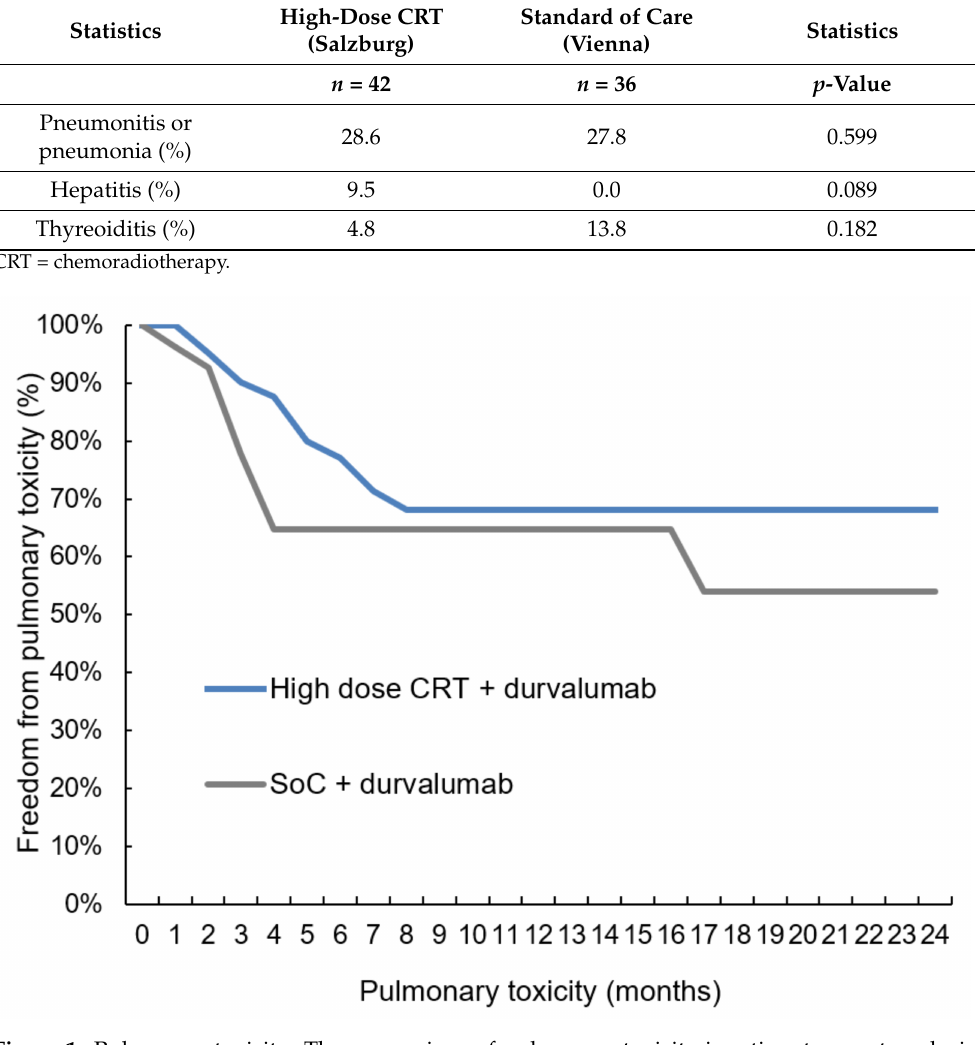
Figure 1. Pulmonary toxicity. The comparison of pulmonary toxicity in a time-to-event analysis revealed no significant difference (log-rank test, p -value = 0.353) between high-dose chemoradiation and standard of care (CRT = chemoradiotherapy, SoC = standard of